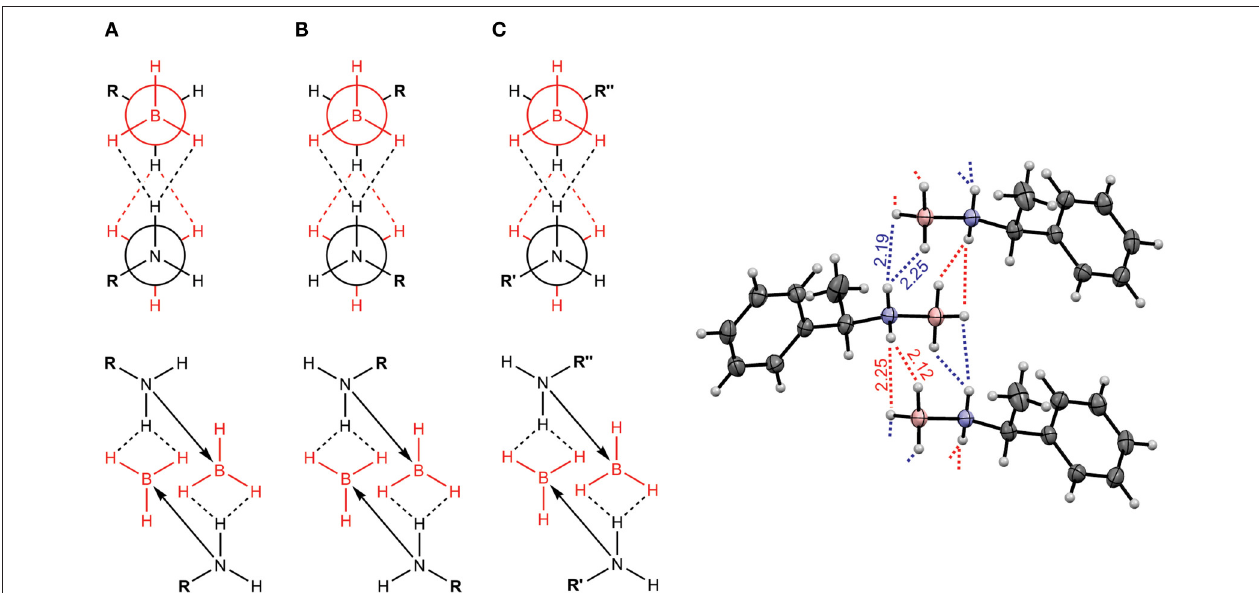
FIGURE 4 | Three possible binding topologies, (A–C), for the methyl-benzyl-amide borane dimer (left) and the crystal structure of the DHB dimer (right). Reproduced with permission from Merten et al. (2014a,b). Copyright 2014, Wiley-VCH Verlag GmbH & Co. KGaA, Weinheim.